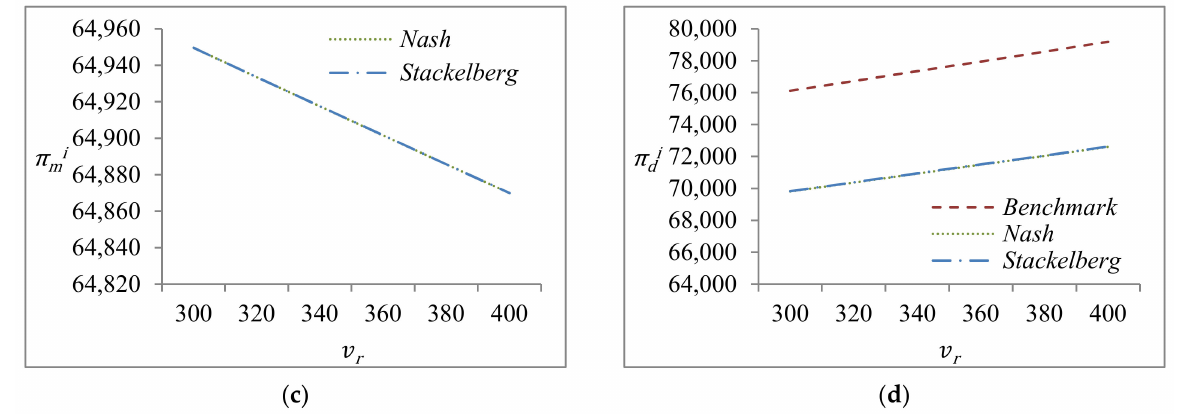
Figure 5. Effect of physical store’s salvage price on: ( a ) manufacturer’s decision; ( b ) retailer’s decision; ( c ) manufacturer’s profit; ( d ) retailer’s profit, when ε value is low. The following market condition is used: r = 0.2, r r = 0.1, ε = 0.005, h = 30, α m = α o = α r = 100, γ = 0.4, γ r = 0.2, p = 900, v r = variable , v o = 20, c d = 420, c m = 100, ∅ = 20.